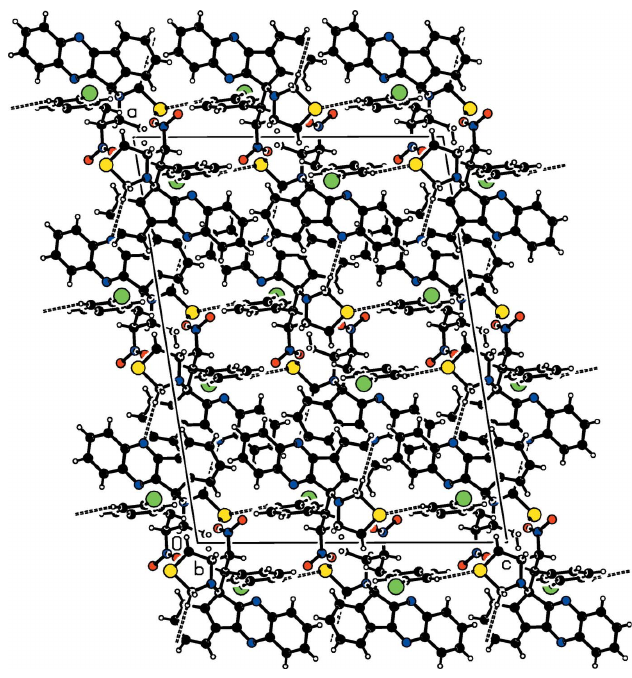
Figure 5 Overall packing of the title compound viewed along the b axis. Hydrogen bonds are shown as dashed lines.